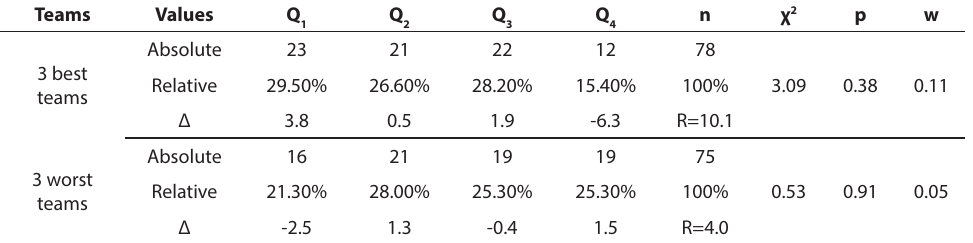
TABLE 3. Comparison of Influence of the RAE in Hockey Players from the 3 Best and the 3 Worst Teams of the